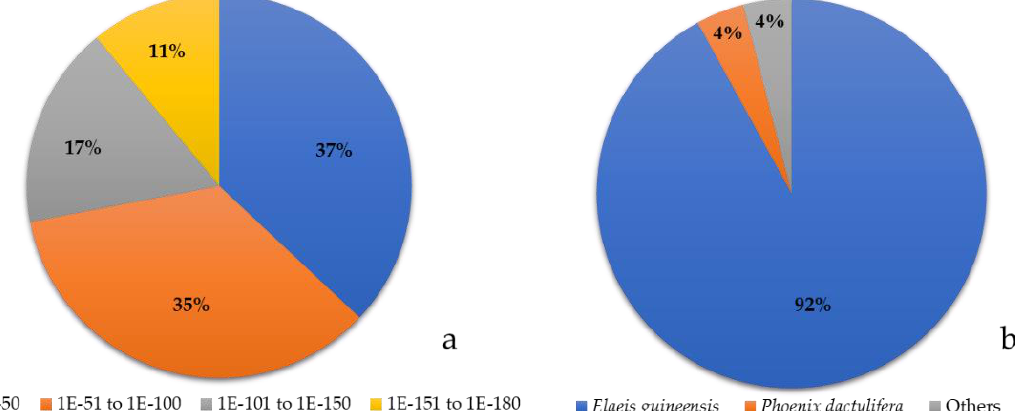
Figure 1 . Distribution of E - value and similarly percentage of nucleotide with other plant species . a . Figure 1. Distribution of E-value and similarly percentage of nucleotide with other plant species.